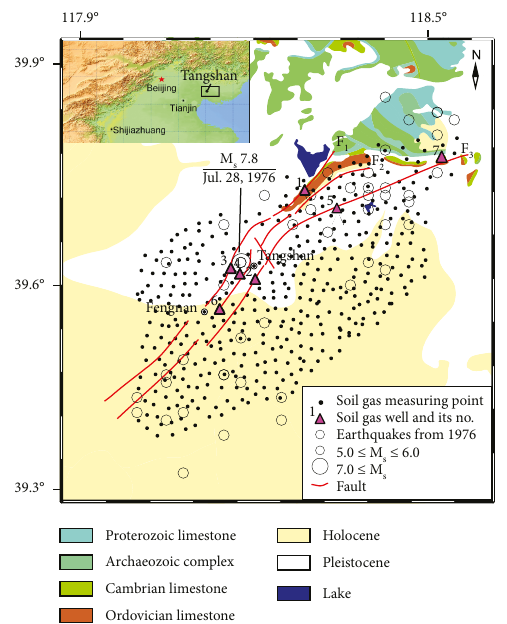
Figure 1: A map of the study area, with inset showing its location in NE China. F : Douhe fault; F 1 Tangshan-Guye